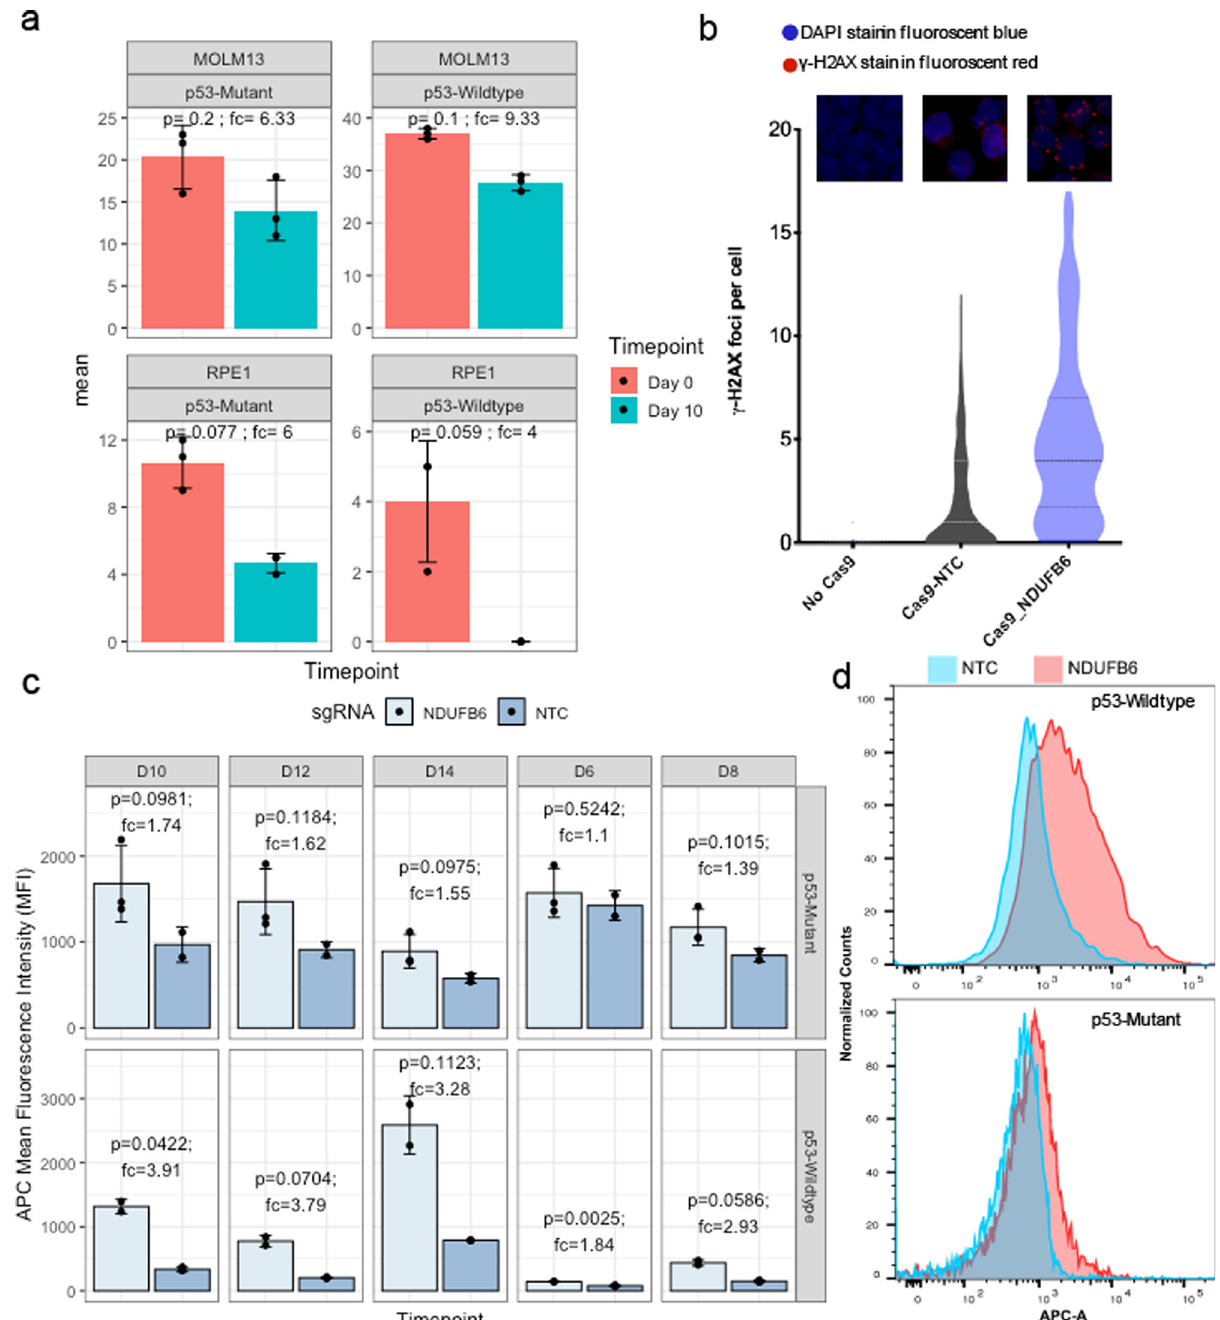
Fig. 4 Transient knockout in both MOLM13 and RPE1 leads to preferential loss of p53 WT over mutant cells. a The editing ef fi ciency of NDUFB6 around the sgRNA cut site was determined in p53 mutant and wildtype isogenic pair of MOLM13 (top panels, transformed cells) and RPE1 cells (bottom panels, primary cells) using ICE protocol (see the “ Methods ” section) at day 0 (orange) and day 10 (green) after Cas9-RNP-sgRNA nucleofection. Differences in day 0 compared to day 10 editing ef fi ciency can be used as a measure of relative fi tness of edited compared to non-edited cells. The p -values are calculated using two-sided Wilcoxon Rank Sum tests. Data are presented as mean values ± SEM across N = 4 independent biological replicates (unique sgRNAs). b DNA damage is quanti fi ed from gamma H2AX ( γ -H2AX) staining images and measured by gH2AX staining in p53 wildtype MOLM13 cells with no Cas9, Cas9 + sgRNA for a non-targeting control (NTC) or NDUFB6. γ -H2AX foci ( y -axis) in all three conditions ( x -axis) are enumerated in the violin plot. c Mean fl uorescence intensity of the CellTrace ™ dye (APC) in MOLM13 p53 mutant (top panel) vs. wildtype cells (bottom panel) is shown for NTC (light blue) or NDUFB6 targeting sgRNAs (dark blue). CellTrace ™ APC fl uorescence is inversely correlated with proliferation. The error bars denote standard error (mean ± standard deviation) across three replicates. The p-values are calculated using a two-sided t -test given a small number of data points ( n = 3). d Proliferative effects of NDUFB6 editing in RNP-transfected p53 mutants compared to wild-type cells. A histogram of MOLM13 p53 wildtype (top panel) cells transfected with an NTC or an NDUFB6 sgRNA is shown with the fl uorescence intensity of the CellTrace ™ dye (APC) on the x -axis. Similarly, MOLM13 p53 mutant cells are plotted in the bottom panel. The error bars are presented and computed as panel ( a